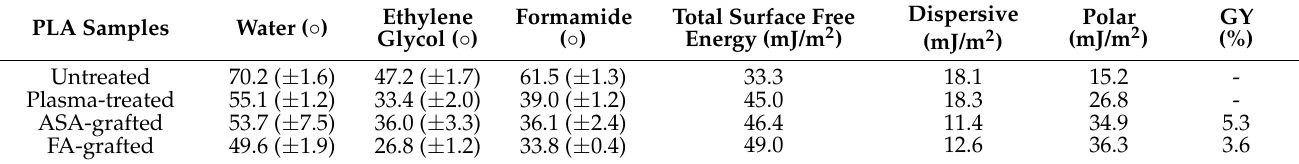
Table 1. The contact angles, surface free energy and graft yields of the PLA samples. PLA Samples